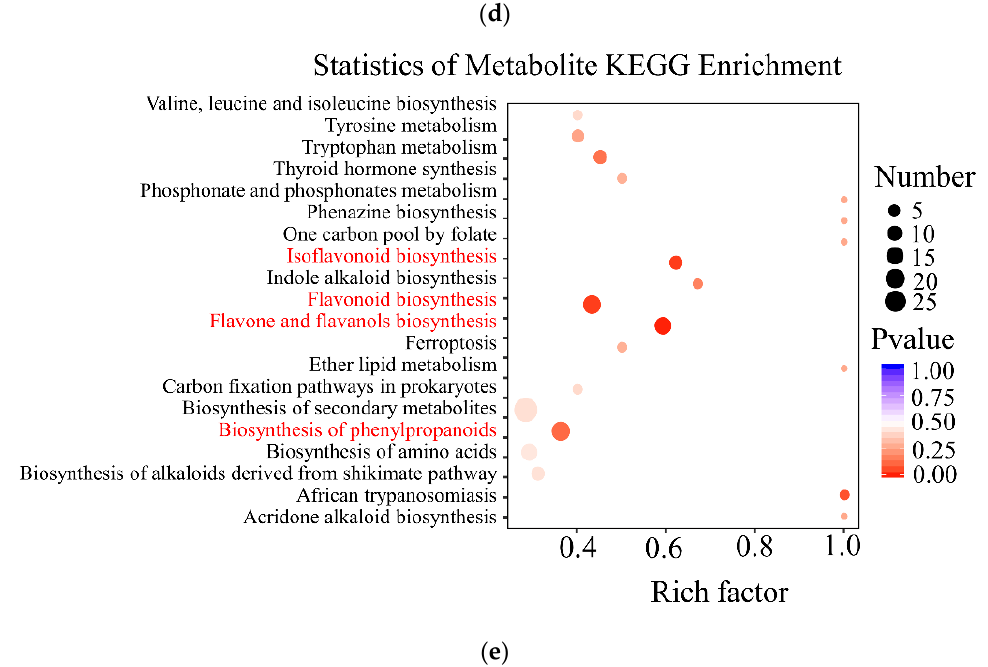
Figure 2. Metabolome analysis of E. ulmoides H11 (green leaves, CK) and H12 (red leaves). ( a ) Statistics of the number of classified metabolites, ( b ) PCA of metabolites, ( c ) OPSLDA model of metabolite differences, ( d ) volcano plot of differentially expressed metabolites (DEMs), and ( e ) KEGG enrichment of DEMs.